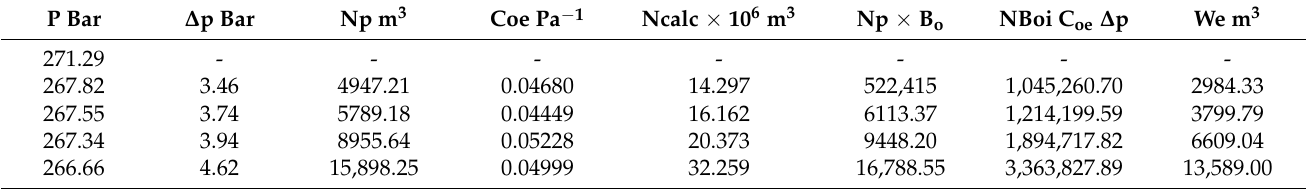
Table 2. Calculation of material balance for the Hummar formation using Hummar PVT data, where